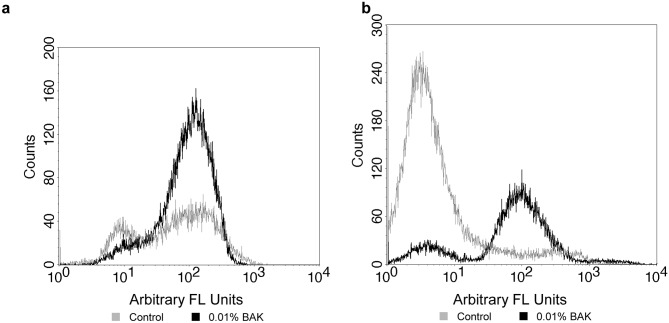
Cell death following BAK exposure as measured by PI staining.The histograms display PI staining in the supernatant (a) and adherent (b) cell population following 24 hour exposure to 0.01% BAK. The grey histogram represents cells from the no lens, no solution control; and the black histogram represents cells exposed to BAK. The positive peak for PI (>10 arbitrary fluorescent units) can be observed in both the control and BAK supernatant population, as cells slough off the stratified culture. A significant increase in cells staining positive for positive for PI can be observed following BAK exposure.